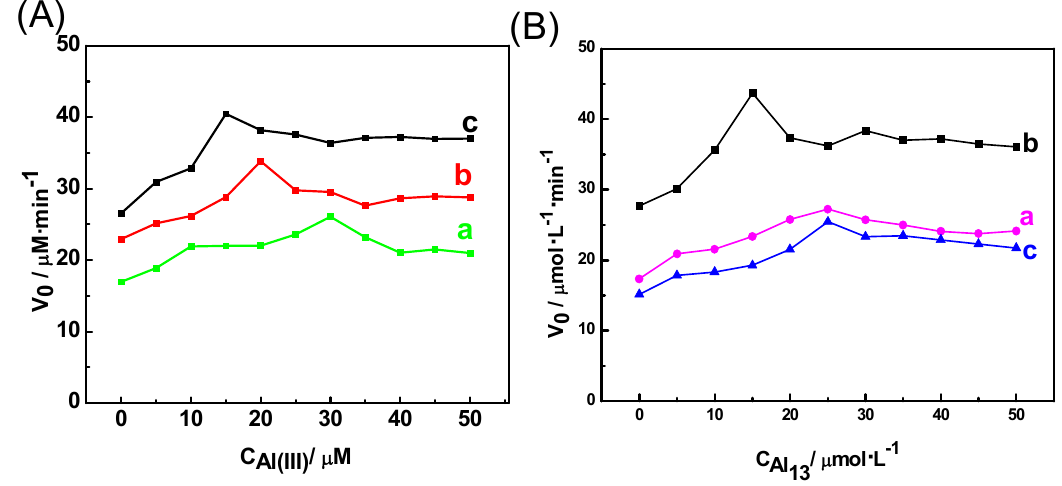
on the v of the oxaloacetate reduction reaction in Figure 3. The effects of Al(III) and Al 13 0 a well-stirred assay mixture: 1 mM oxaloacetate + 1 mM NADH + 100 mM Tris-HCl buffer at different pH. Reaction was initiated by addition of 10 μ L MDH. ( A ): ( a ) pH 8.5 ( b ) pH7.5 ( c ) pH 6.5 ( B ): ( a ) pH 8.5 ( b ) pH 7.5 ( c ) pH